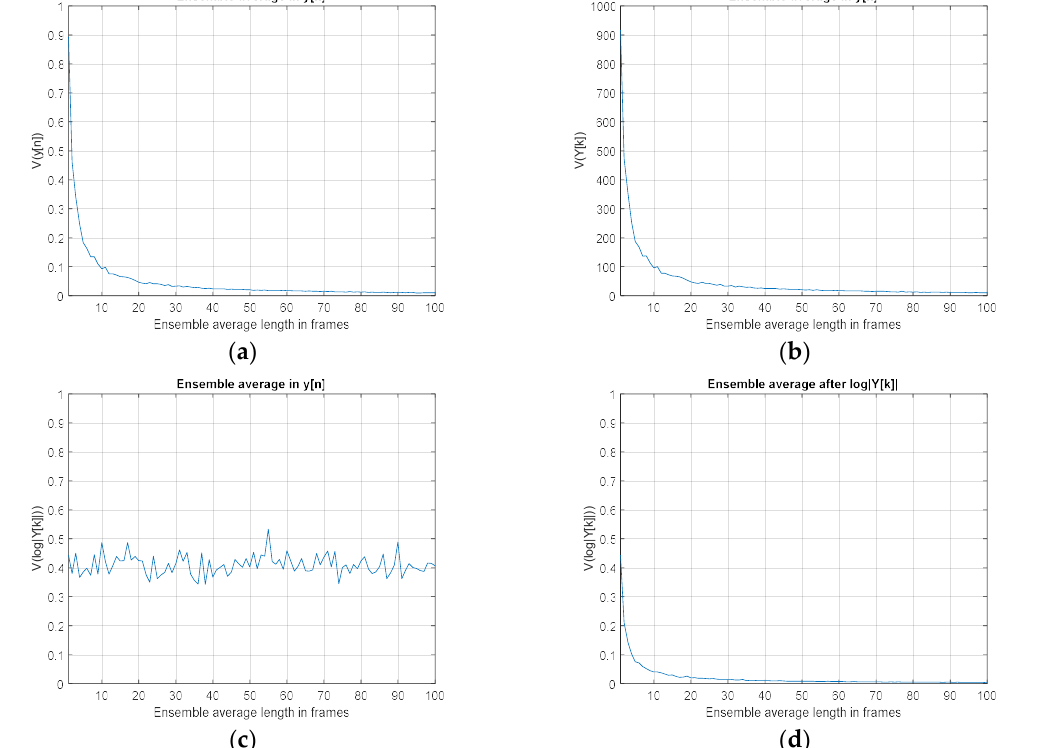
Figure 6. Signal variance at each computational stage of HD algorithm with pure noise situation as 𝑦[𝑛]~𝒩(0,1) . The frame size is 1024 samples: ( a ) variance of y [ n ] with ensemble averaged y [ n ]; ( b ) variance of Y [ k ] with ensemble averaged y [ n ]; ( c ) variance of log| Y [ k ]| with ensemble averaged y [ n ]; ( d ) variance of log| Y [ k ]| over ensemble averaged log| Y [ k ]|.